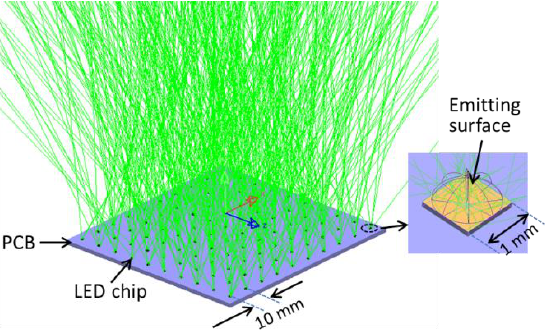
Figure 2. A rectangular array of LED chips was integrated into the printed circuit board (PCB) as a light source for the illumination system.